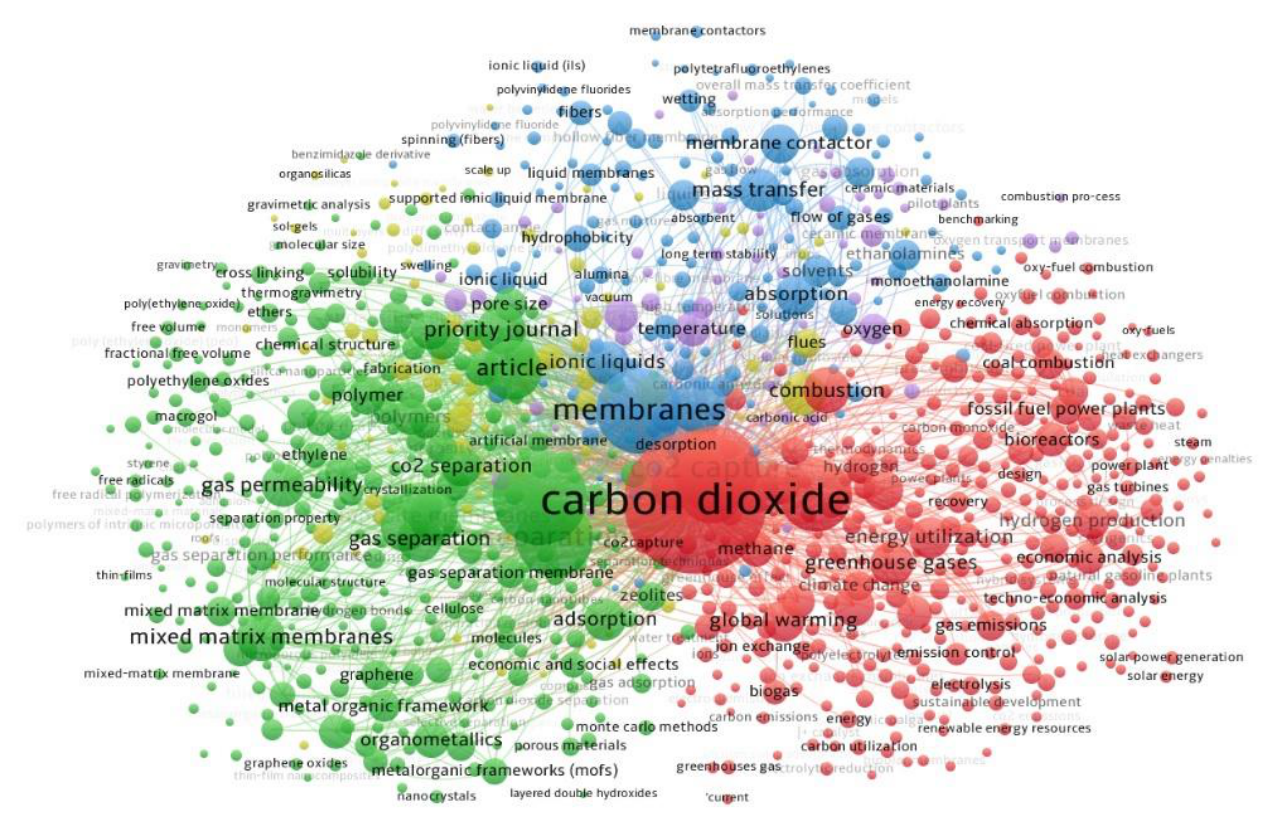
Figure 6. Keyword co-occurrence network visualization of search results. Nodes represent keywords in the network map, whereas arcs represent co-occurrence relationships between nodes and indicate that they have become linked